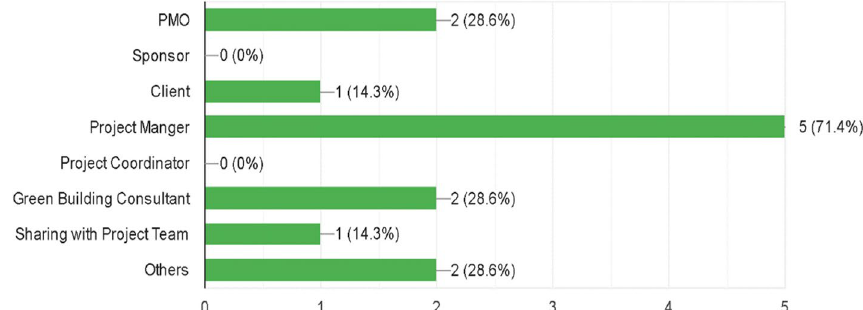
Fig. 6 Responsibility for defining project management methodologies and software. Ref: Researchers